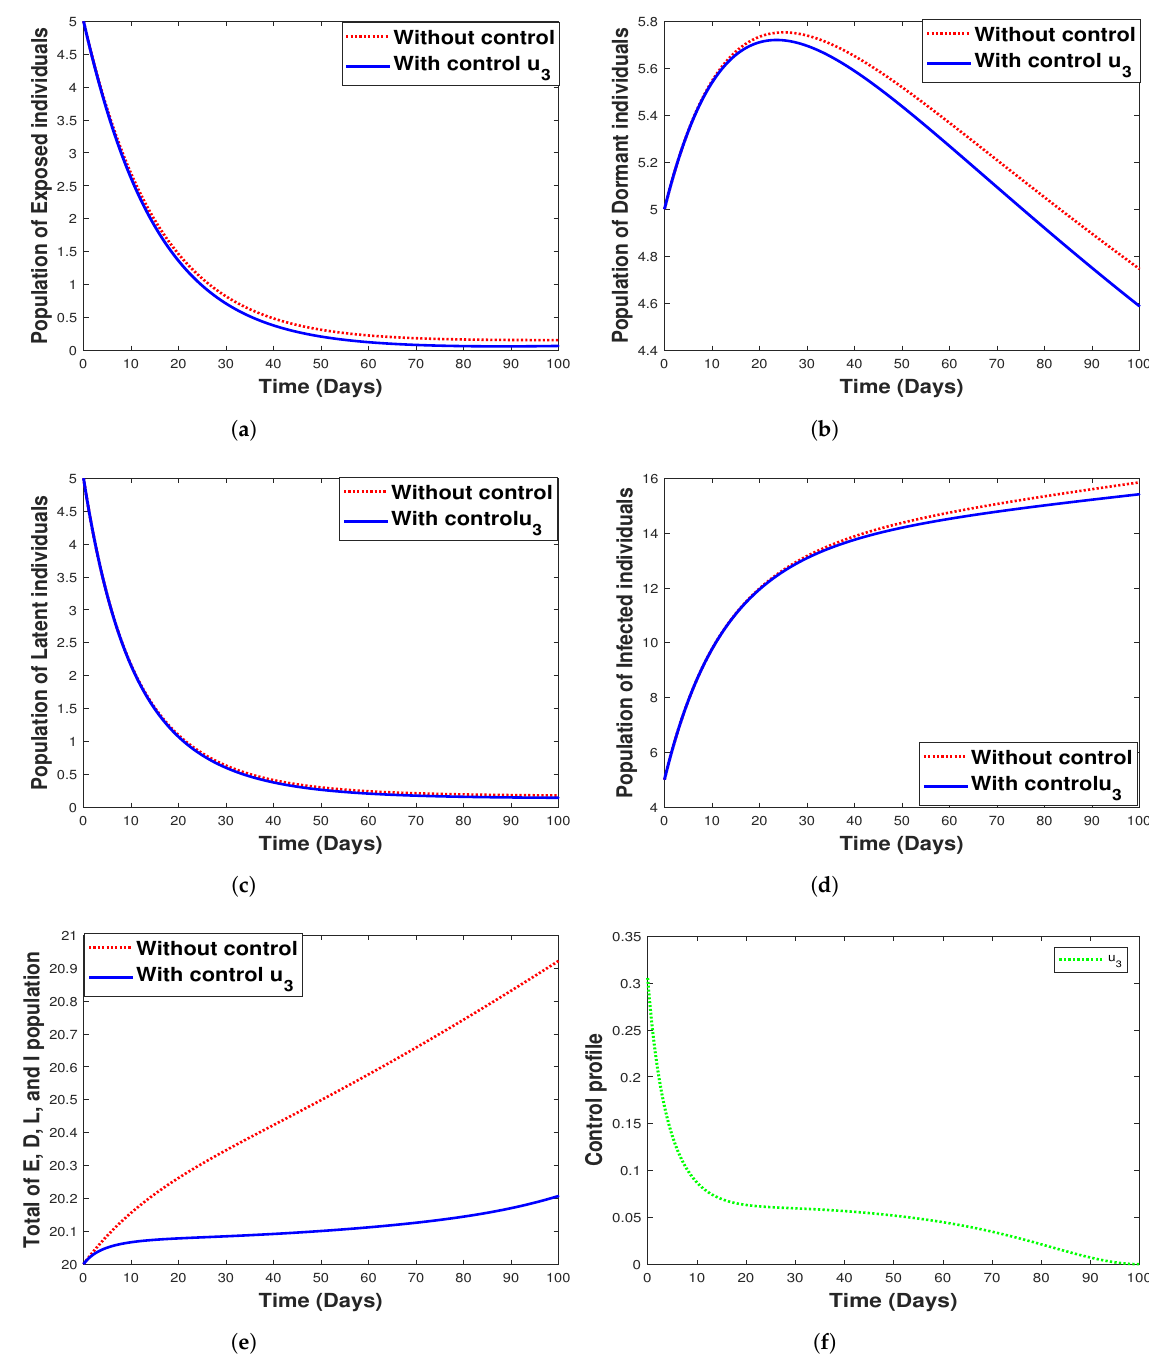
Figure 14. Simulation results for strategy 3 shows the dynamics of exposed compartment, dormant compartment, latent compartment, infected compartment, total of exposed, dormant, latent, and infected population, and the dynamic of control u 3 for subfigure ( a )–( f ),